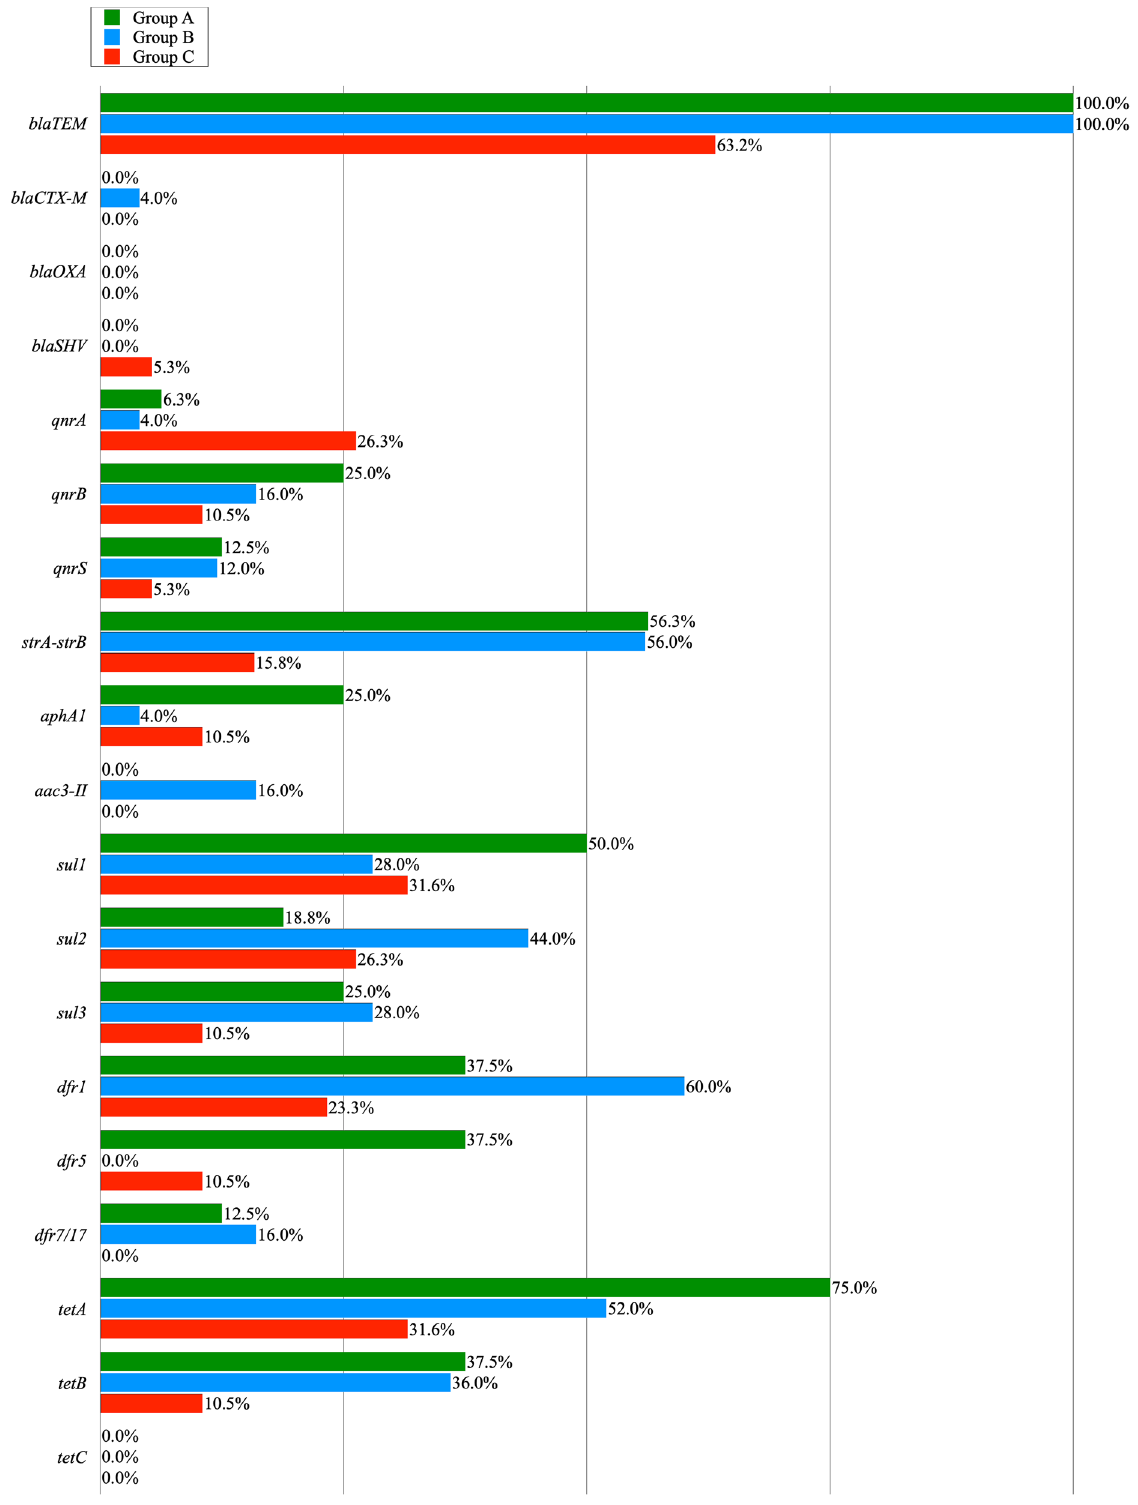
Figure 2. The prevalence of resistance genes among the MRD resistant E. coli isolates obtained from poultry litter (Group A), cloacal swabs (Group B) and poultry meat (Group